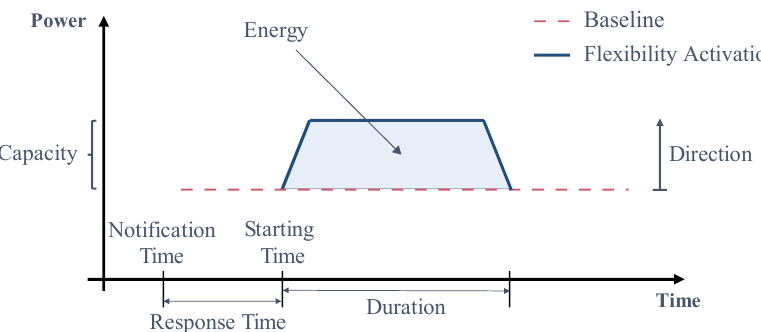
Figure 2. Example of flexibility activation with relevant